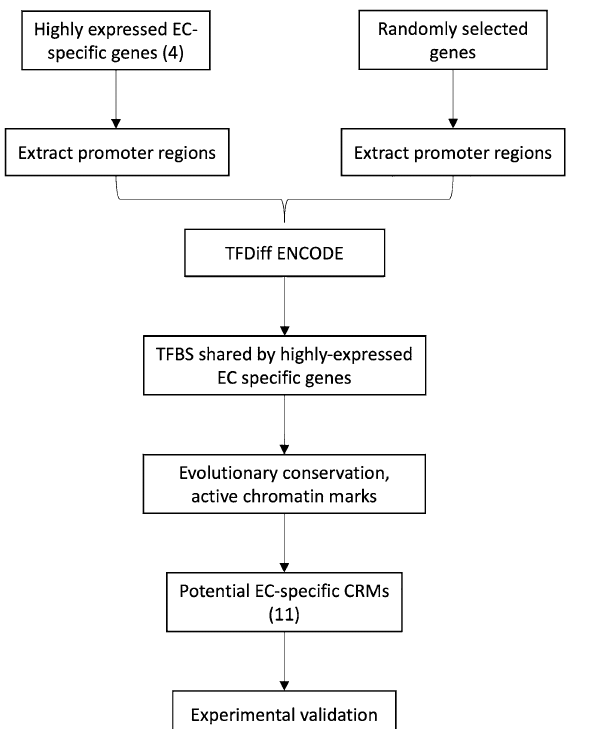
Figure 3. Bioinformatics-based approach used to identify and test 11 potential endothelial cell (EC)-specific cis-regulatory modules (CRM; see “Methods”). Essentially, promoter regions of 4 highly expressed EC genes were analyzed to identify sequences that bind transcription factors and are likely transcriptionally active. TFBS, transcription factor binding